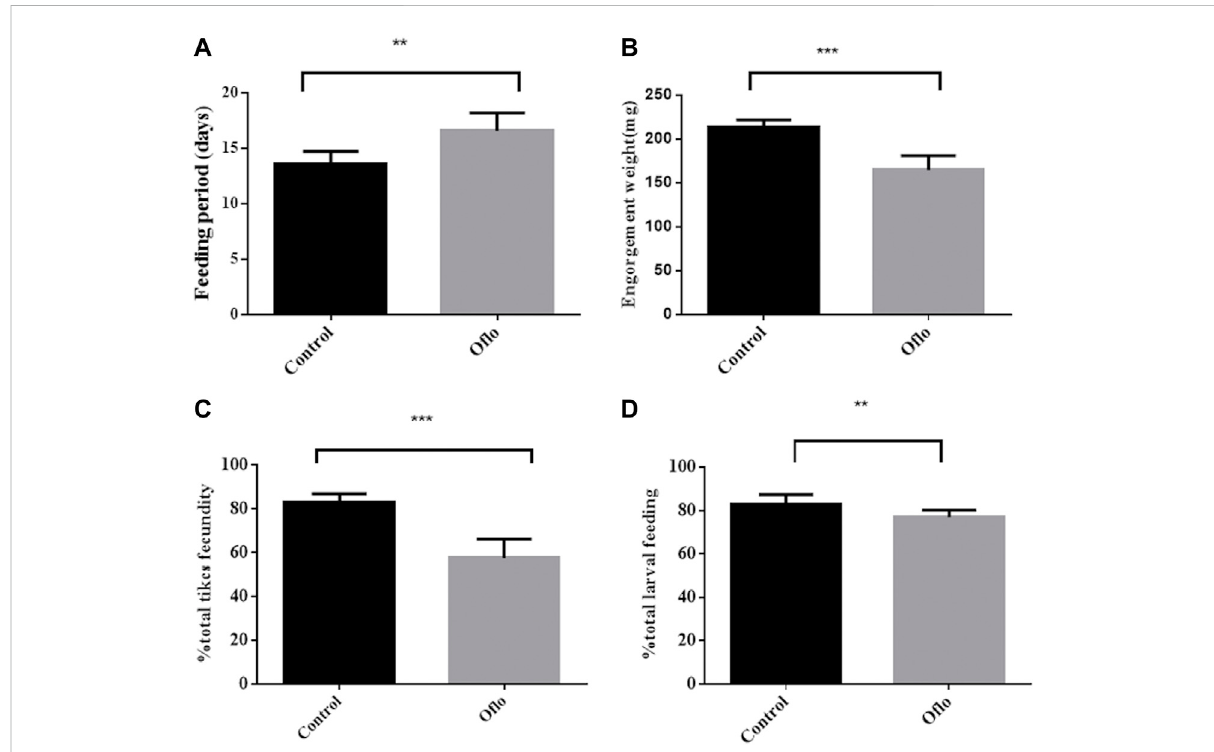
FIGURE 6 Effects of o fl oxacin injection on nymphal and larval development Nymphs were injected with normal saline (control), o fl oxacin-containing saline(o fl o)atadoseof30 ng/mgtickbodyweight(OFX).Feedingperiod (A) ,engorgementweight (B) ,fecundity (C) ,andlarvalfeedingrate (D) were shown. For male and female nymphs, n = 11 per group, with different letters for signi fi cant differences between groups ( p ≤